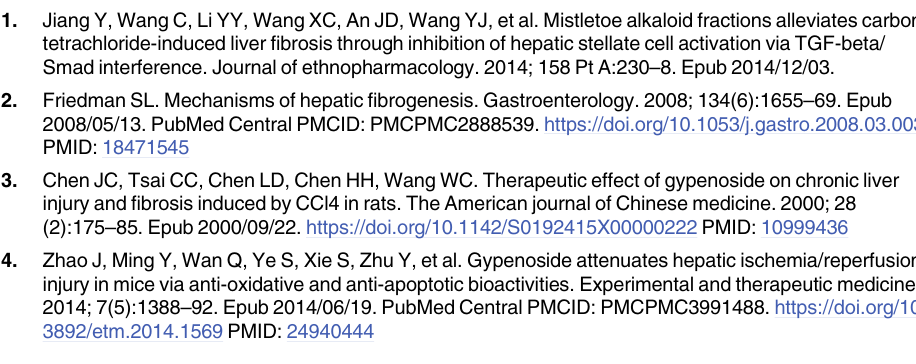
S1 Table. Gene symbols of significantly regulated 597 proteins between gypenoside group and model group. S2 Table. Metabolomic data of liver tissue in rats using GC/MS technology. S1 Fig. Cluster analysis in the expression of those all 2627 proteins. S2 Fig. Validation of the PLS-DA model by 50 permutations of